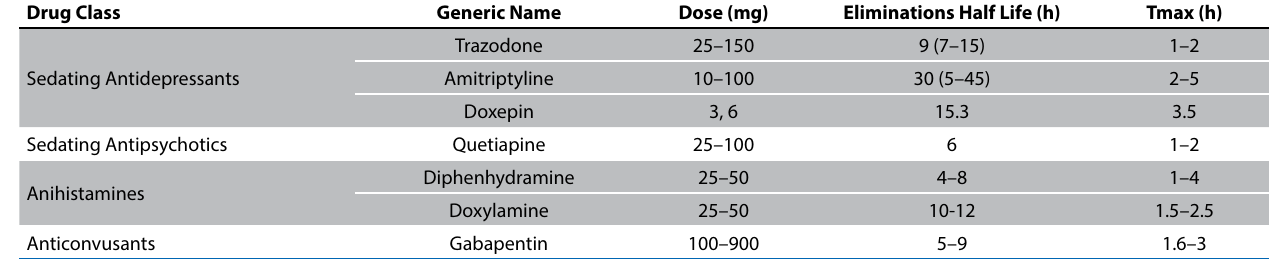
Table 4. Summary of Off-label medications for insomnia 55 Drug